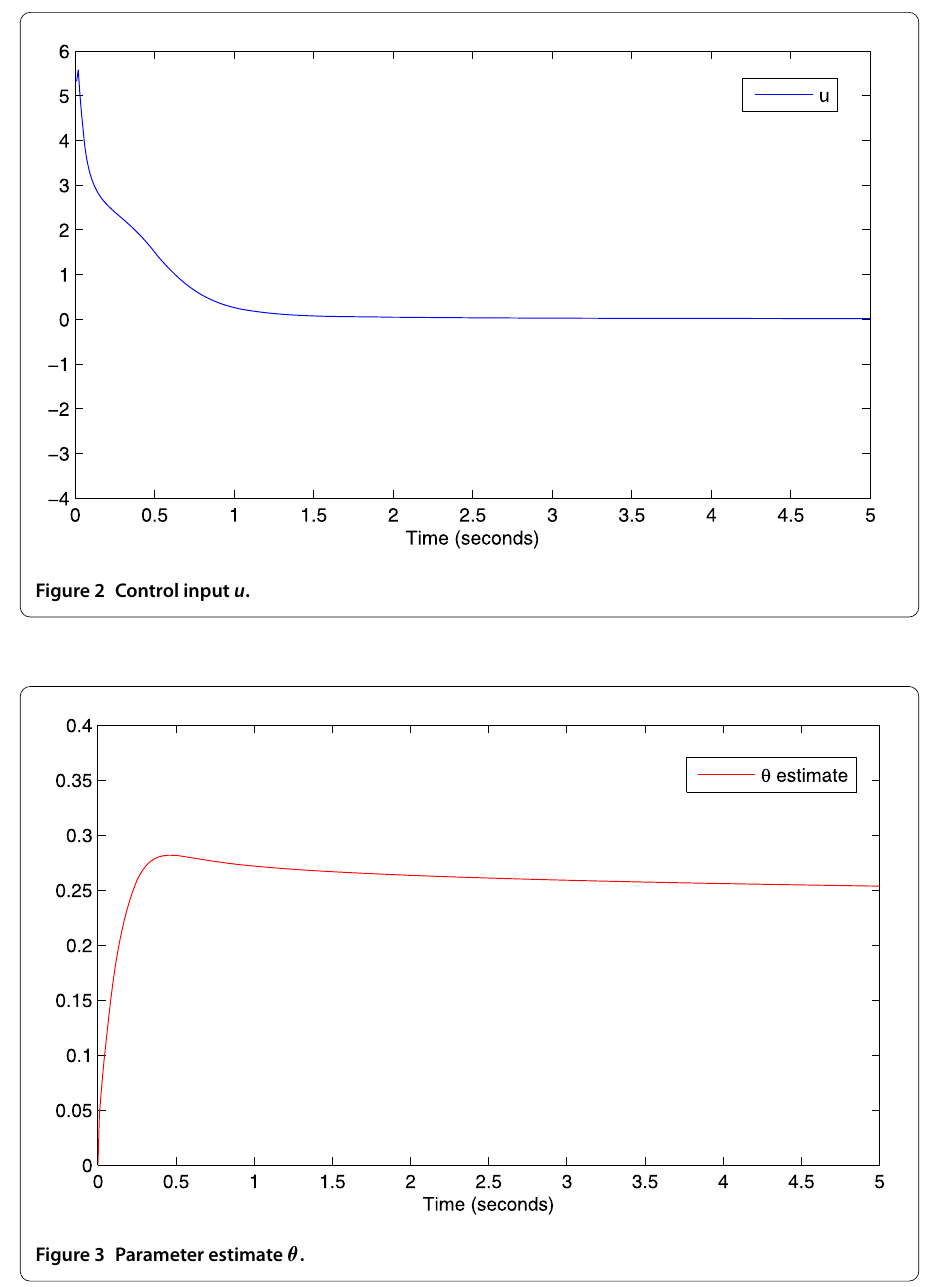
Figure 3 Parameter estimate θ